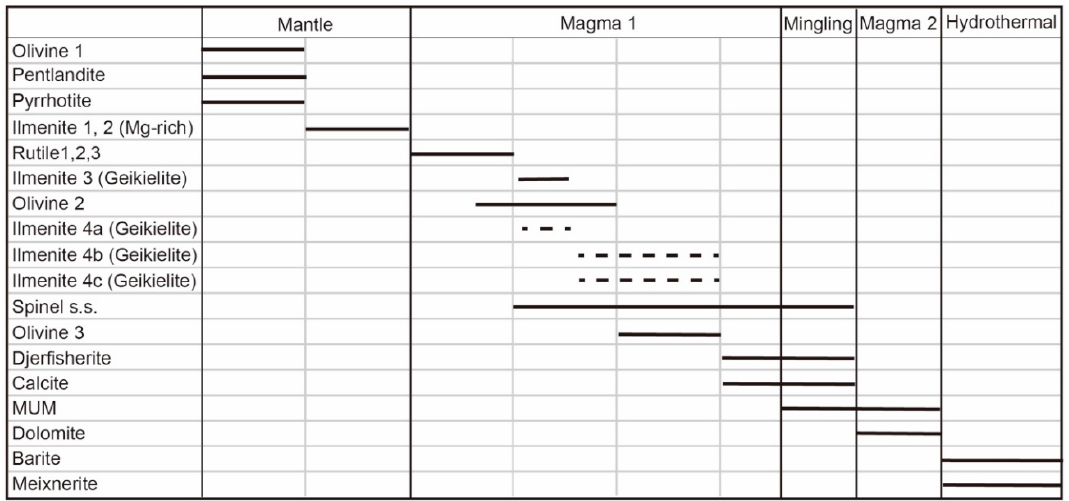
Figure 9. Paragenetic sequences of the crystallization of minerals in site 73 Menominee kimberlites.